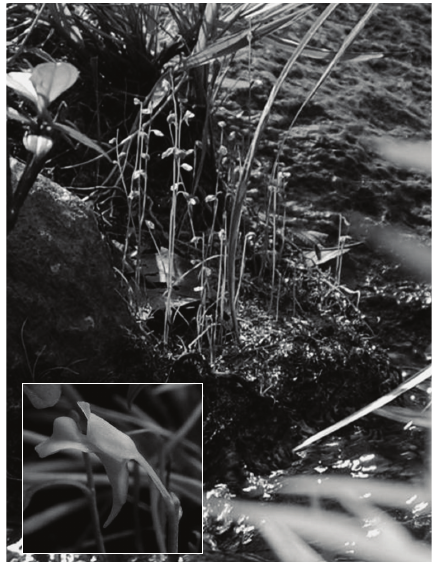
Figure 1: Utricularia bifida —the most common terrestrial species often found along waysides.